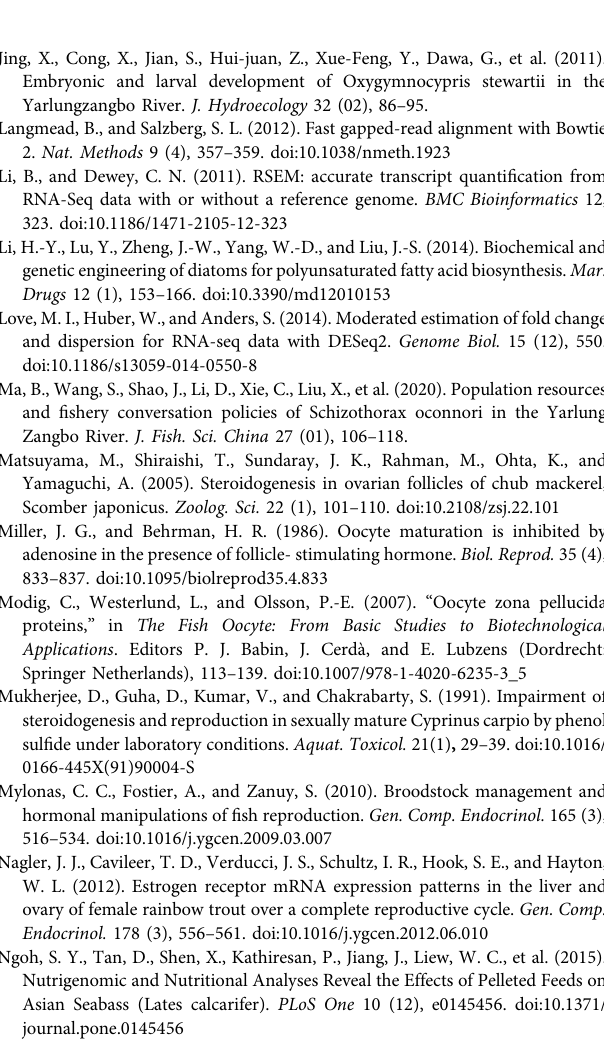
Supplementary Table S2 | KEGG analysis of differentially accumulated metabolites. Supplementary Table S3 | Differentially expressed genes. Supplementary Table S4 | GO and KEGG analyses of differentially expressed genes between LD and LW. Supplementary Table S5 | Primers used for qRT-PCR analysis. Supplementary Table S6 | Metabolite-gene